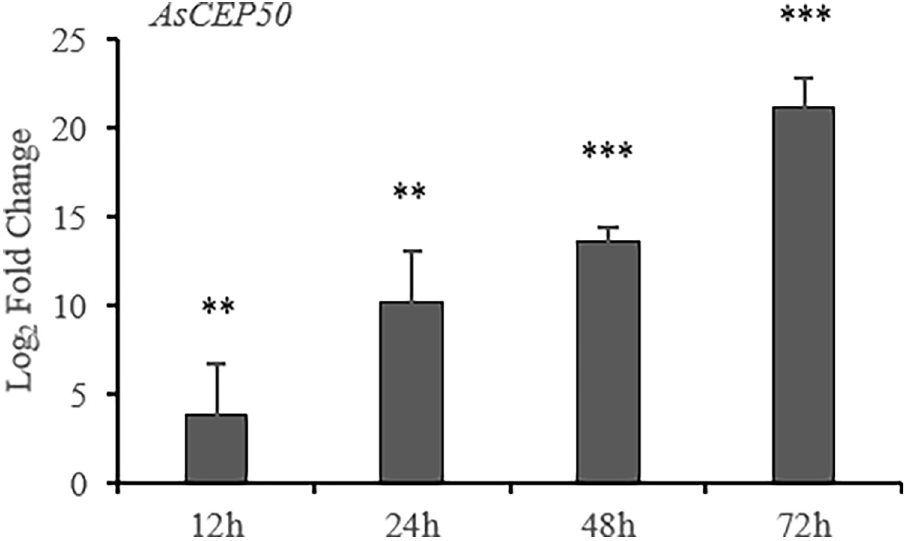
Fig 1. Expression patterns of the AsCEP50 gene during the infection of potato leaves. The expression level at the hyphal stage was used as a control to analyze the specific expression at the infection stage. Student’s t-test was used as a significance test of difference (n=6). �� , indicates a significant difference (0.001 < p < 0.01) compared with the control (hyphae stage); ��� , indicates an extremely significant difference (p < 0.001) compared with the control. Error bars represent the standard deviation (SD) of four biological replicates and two technical